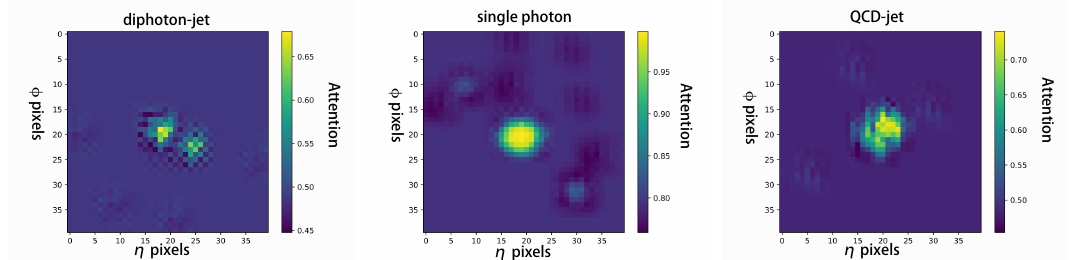
Figure 7 . Attention obtained by the training samples for the QCD-jets, single photons and diphoton-jets when m = 3 a